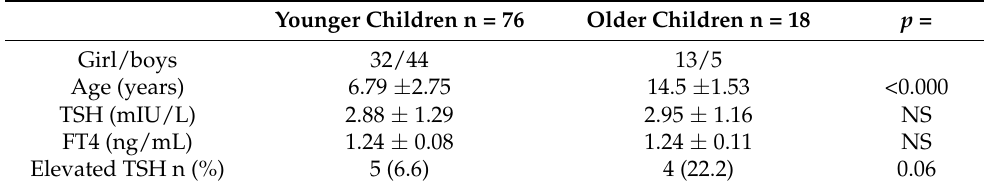
Table 4. Characteristics of the analyzed group of children depending on the age (the younger group: boys <12 years old and girls <11 years old) and the older group: boys ≥ 12 years old and girls ≥ 11 years old).